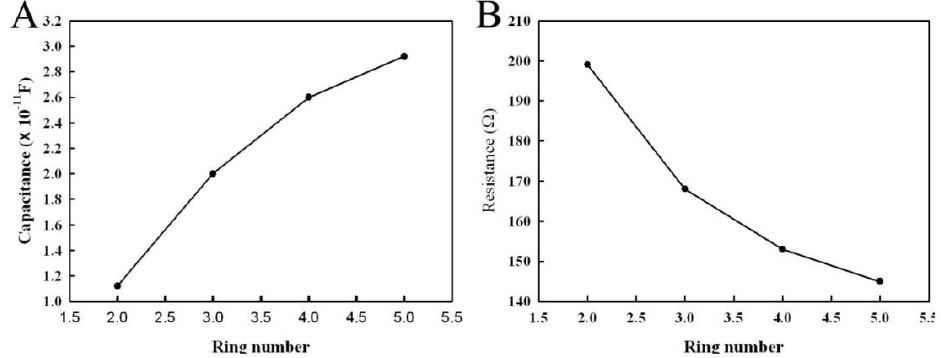
Figure 5. Influence of the number of annuluses on the electric parameters. ( A ) Influence of the number of annuluses on capacitance. ( B ) Influence of the number of annuluses on resistance. of annuluses on capacitance; ( B ) Influence of the number of annuluses on